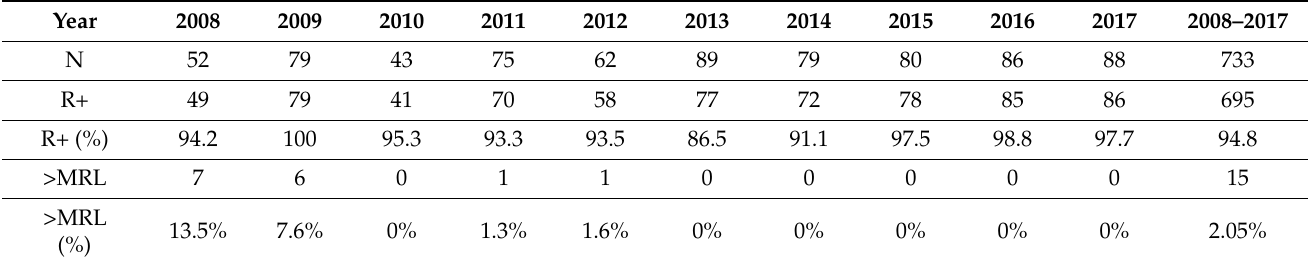
Table 5. Summary of pesticide residue occurrence in